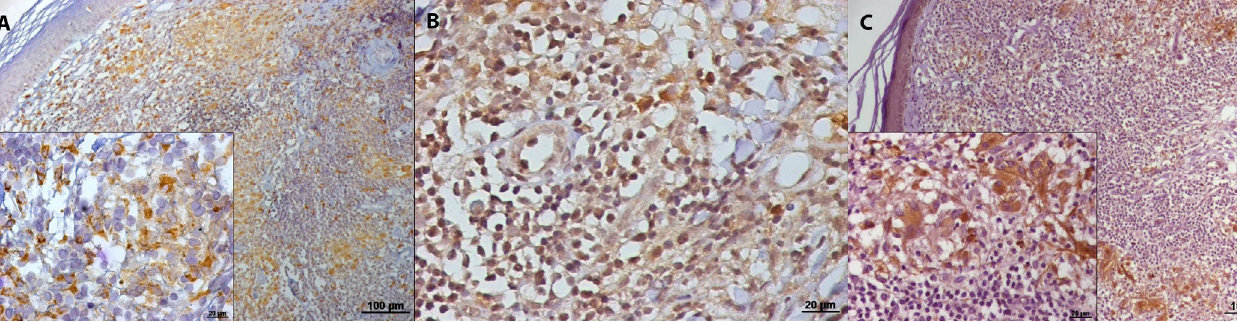
Figure 3. Photomicrographs of immunohistochemitry reaction in histological sections of skin lesions of patients with non-ulcerated or atypical cutaneous leishmaniasis showing in the dermal inflammatory infiltrate: (A) macrophages (CD68 + ); (B) IFN-γ + and (C) iNOS +